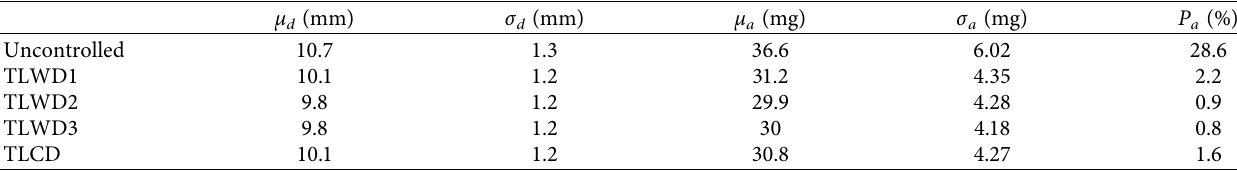
Table 13: Motion performance for TLWDs installed over the last 15